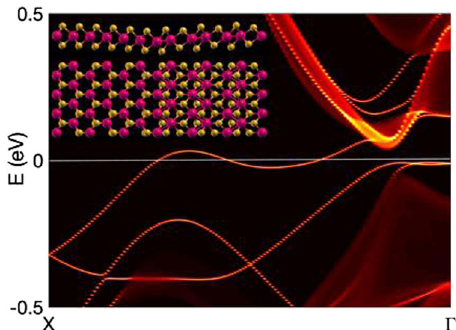
Fig. 4 Density functional theory (DFT) calculation of a single 1T ′ -2H interface. Density of states as function of wave vector parallel to the 1T ′ -2H interface projected in the vicinity of the interface (schematically shown in Fig. 3 Magnetic- fi eld dependence of conductance and scanning tunnel the inset). The inverted bulk bands and the bulk gap opened by spin-orbit spectroscopy (STS) spectra. a Out-of-plane magnetic- fi eld ( B ⊥ ) coupling can be seen near Gamma. The brightness re fl ects the weight of dependence of conductance at gate voltages corresponding to the R the states near the interface. The thin lines continuously connecting the plateaus in Fig. 2b, d (red and blue symbols) and away from them (black conduction band with the valence band correspond to the protected helical symbol). Insets: schematic views of band diagrams with the Fermi level ( E F ; states located at the interface. The protection is evident from the fact that red lines) near and away from Kramers degeneracy point (KDP) for each the interface band crosses three times the Fermi energy (set to zero) or, in V B general, an odd number of times if small deviations of the Fermi energy are ⊥ , suggesting bg . Black symbols remain almost unchanged on increasing that E F stays away from KDP (left upper inset). In contrast, red and blue allowed within the symbols exponentially decrease with B ⊥ , suggesting that E F at B ⊥ = 0 stays near KDP (left lower inset) as a Zeeman gap opens with increasing B ⊥ (right inset). These results support our interpretation that the R plateau values in Fig. 2b, d originate from the quantum spin Hall (QSH) phase. b Examples of STS spectra for laser-irradiated 1T ′ region. The two bulk signals (blue and green curves) were measured near the center of the 1T ′ region, and the edge signals (red solid and dotted curves) were measured near the boundary of the 1T ′ /2H phases. V bg was set to + 35 V ( R maximum) and + 10 V (away from it) for the three solid curves and the dotted one, respectively. Insets: schematic views of band diagrams as in a . The red dotted curve with non-zero d I/ d V values suggests that E F lies away from the bulk gap (upper inset). In contrast, gaps of varying magnitudes are manifest in the other three solid curves, suggesting that E F lies in the bulk gap near KDP, as expected for the QSH phase. c Distribution of bulk gaps Δ observed by STS on 10 different bulk points along the sample longitudinal direction in the 1T ′ regions at T = 2 K and V bg ∼ 35 V. Red and black symbols correspond to Δ values obtained under 4.6-mW- and 17- mW-power laser beam irradiation, respectively. Error bars show the dispersion obtained from measuring on three different spots (within ∼ 50 nm distance) at the same longitudinal position. The larger Δ values with the smaller dispersion of the red symbols suggest an improvement of the 1T ′ crystal quality upon a reduction of laser power.